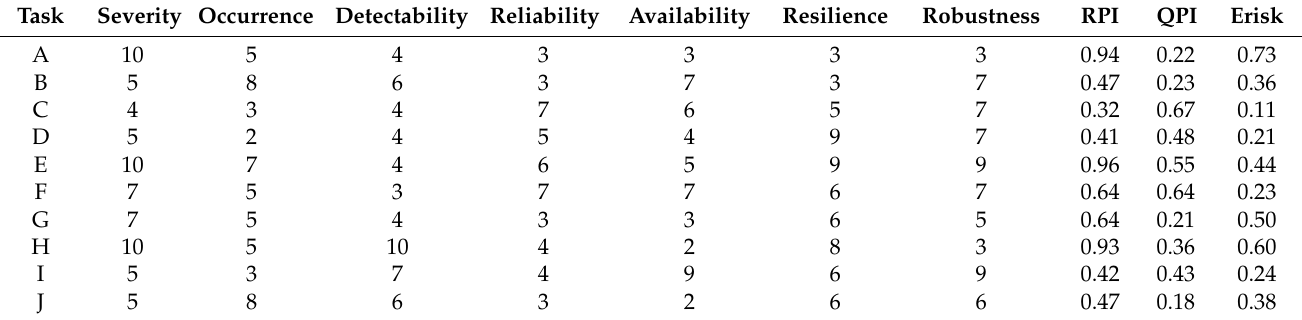
Table 7. Effective risk assessment of team 2 in each project task.